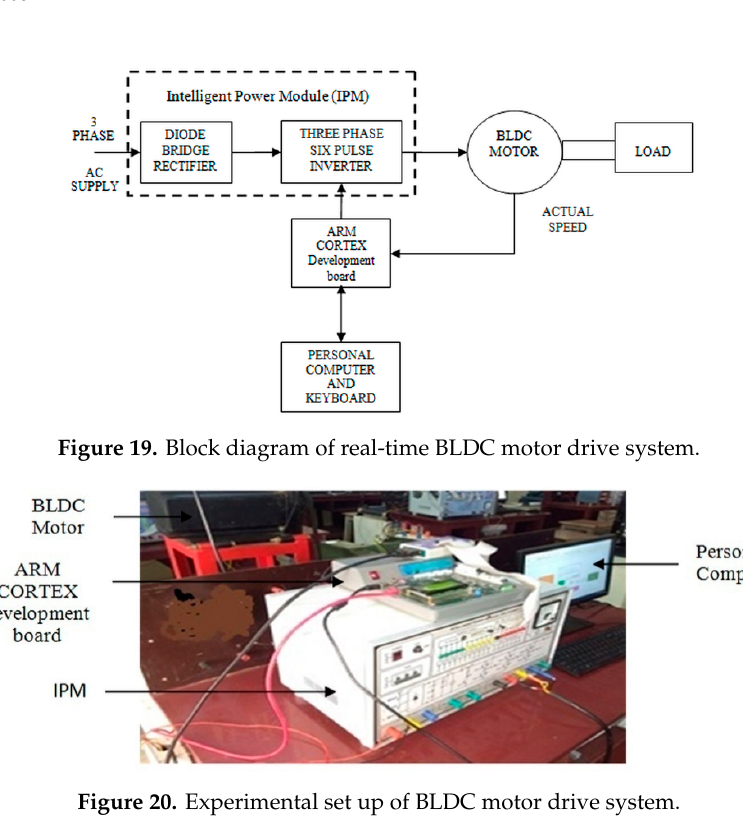
Figure 20. Experimental set up of BLDC motor drive system.